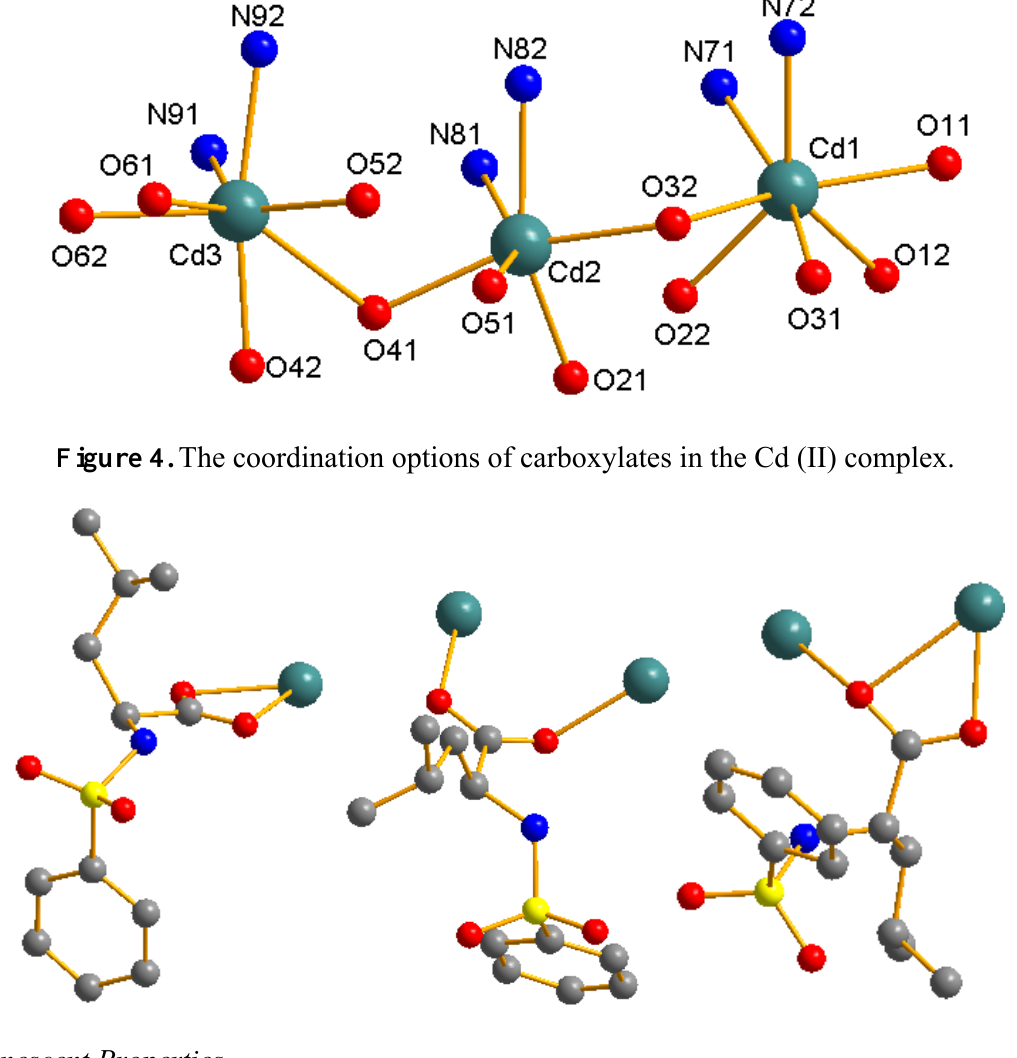
Figure 3. The coordination environment of the Cd (II) ions.